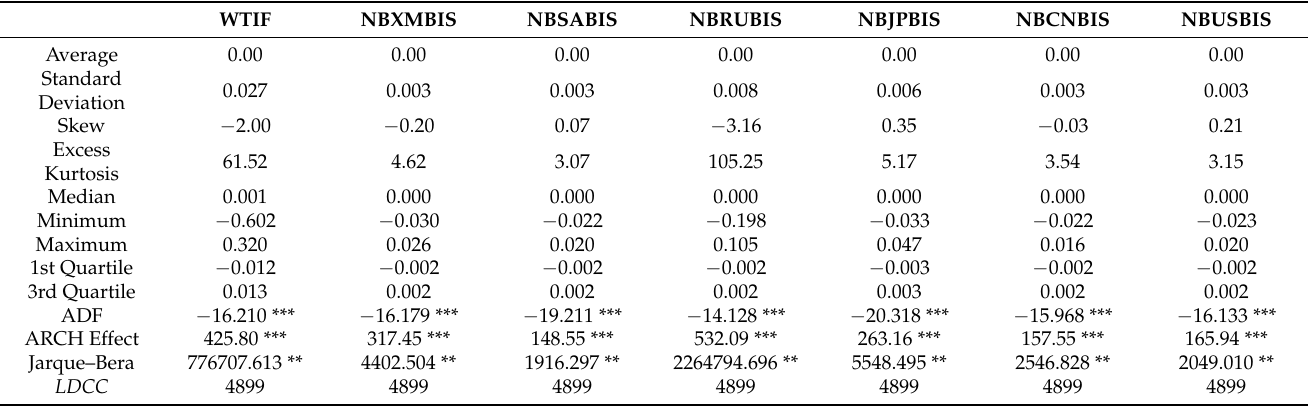
Table 2. Variables used in the